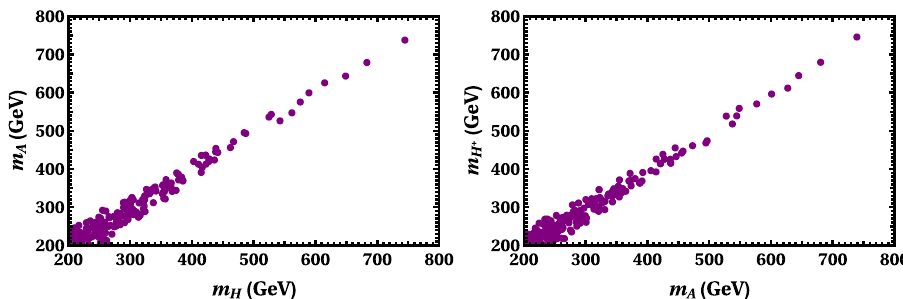
Fig. 8 The scanned parameter space in the m A – m H (left) and m A – m H ± (right) plane that can provide successful R 2 -Higgs